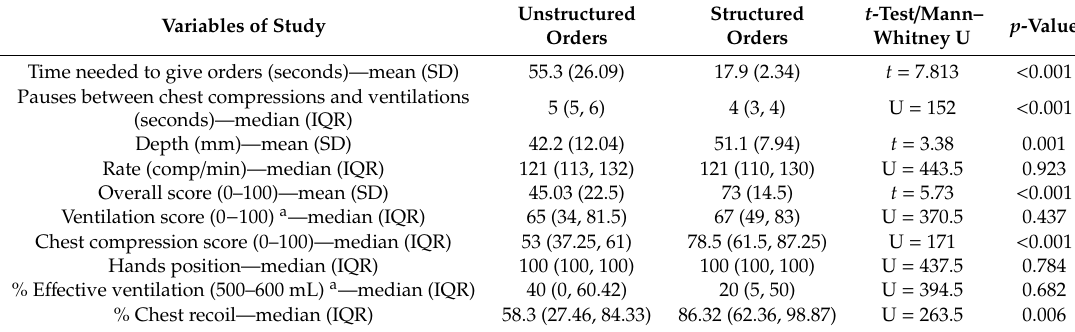
Table 2. Study outcome data.